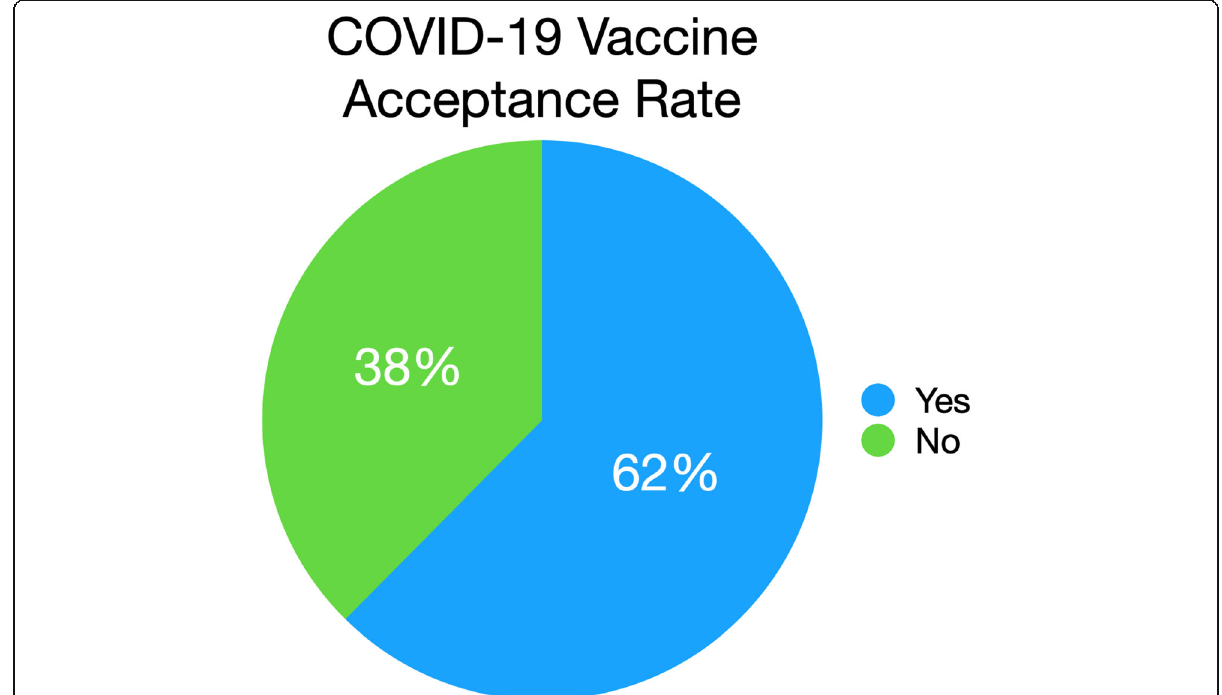
Fig. 1 COVID-19 vaccine acceptance rate in the Arab world